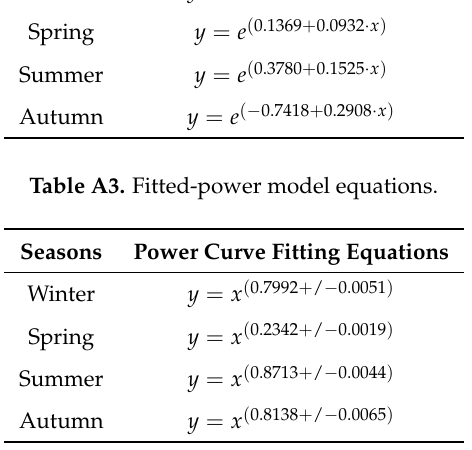
Table A4. Regression model